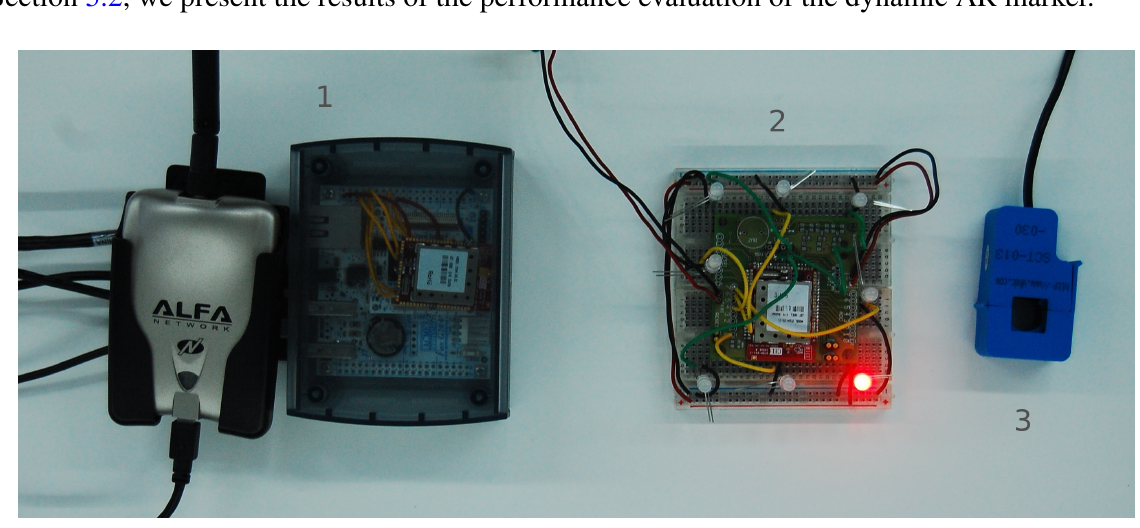
Figure 14. Main components of the laboratory testbed: (1) border router and gateway; (2) dynamic marker; (3) amperometric